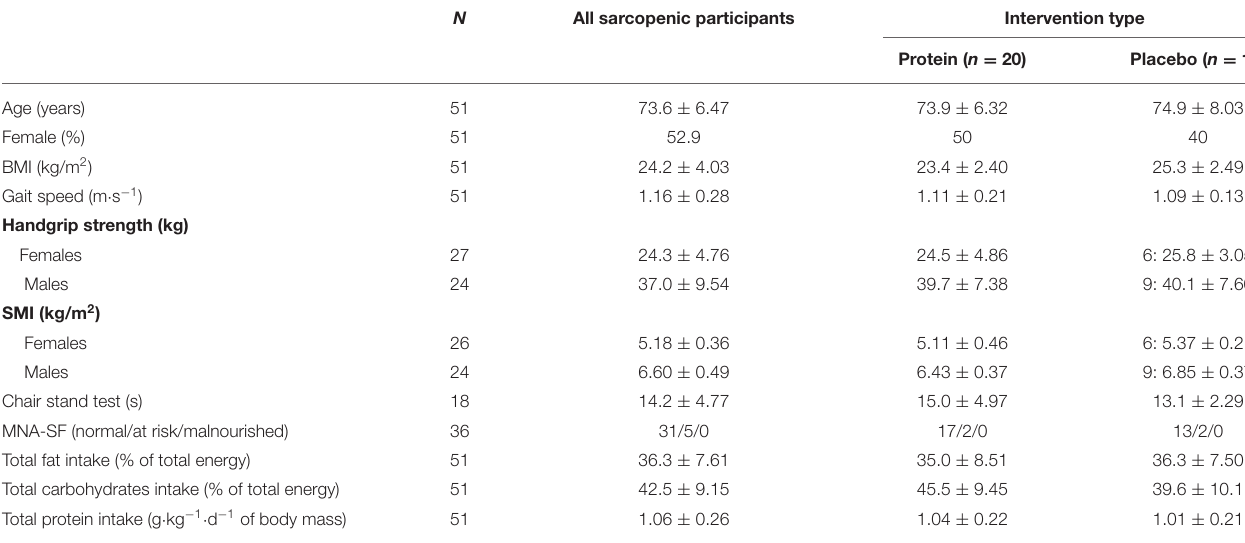
TABLE 1 | Characteristics (mean ± SD) of community-dwelling (pre)sarcopenic older adults at start of the intervention period.